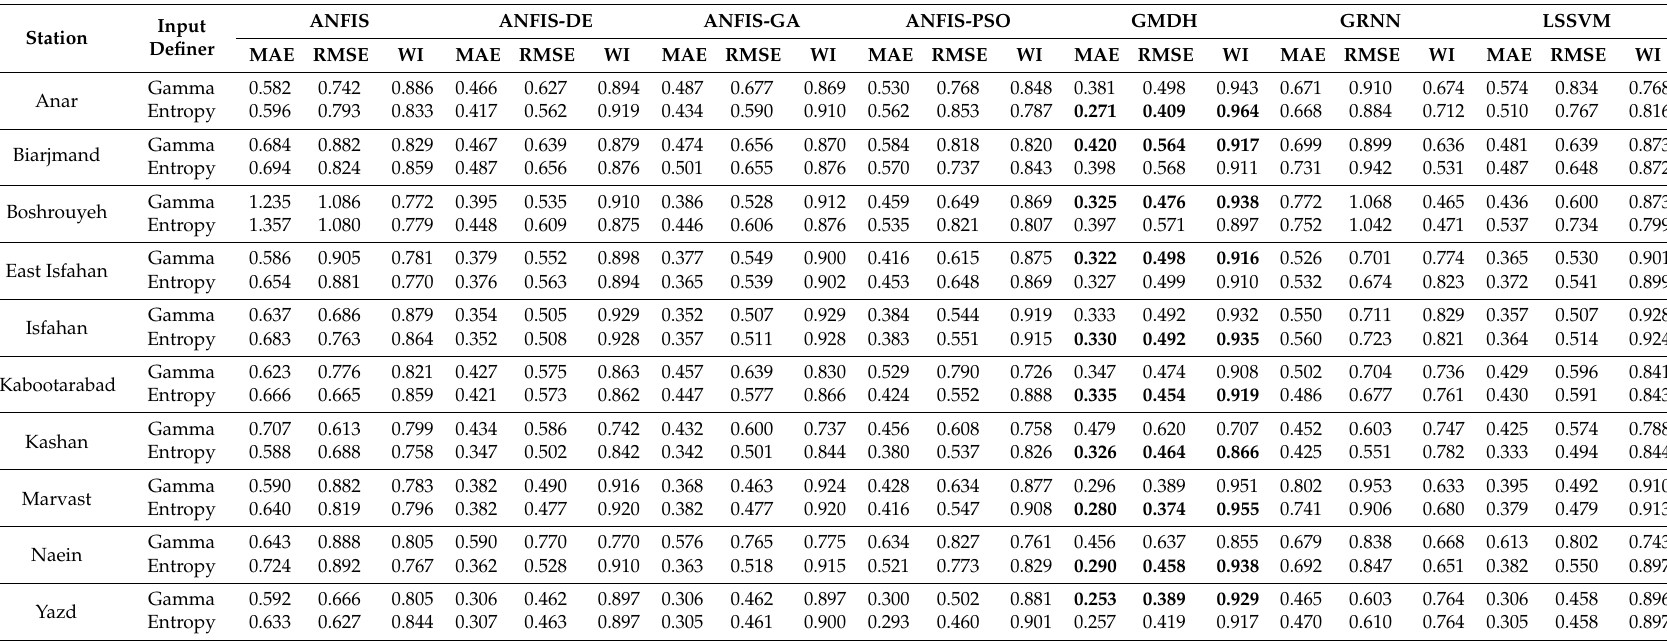
The bold numbers are the best performance of each station, on its own